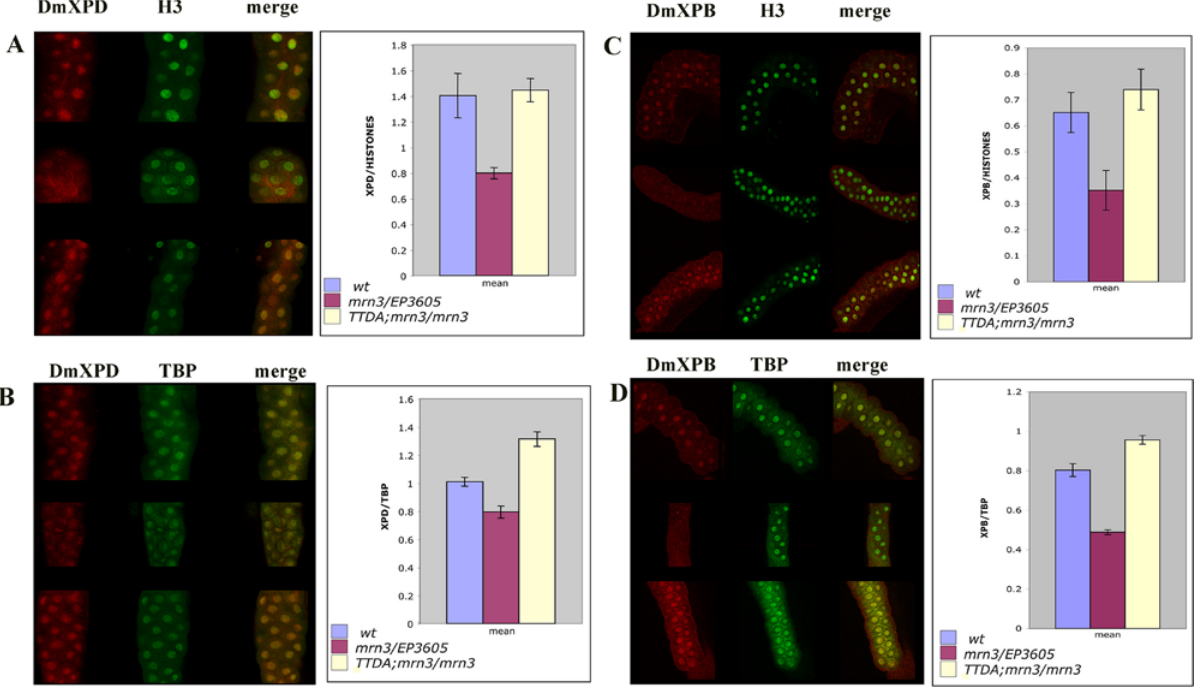
Figure 4. Dmp8/TTDA overexpression recovers XPD and XPB levels in Dmp52 mutant flies. Salivary glands from third instar larvae of wild- type, heteroallelic EP3605/mrn 3 and homozygous mrn 3 flies with two copies of the Dmp8/TTDA transgene in chromosome 2 (TTDA/ + ; mrn 3 /mrn 3 ) were dissected and co-immunostained with H3 and XPD anti-antibodies (panel A), TBP and XPD antibodies (panel B), H3 and XPB antibodies (panel C) or XPB and TBP antibodies (panel D). XPD/H3, XPD/TBP, XPB/H3 and XPB/TBP ratios were calculated using nuclei from at least ten salivary gland cells in each condition. The error bars indicate standard errors of the means.